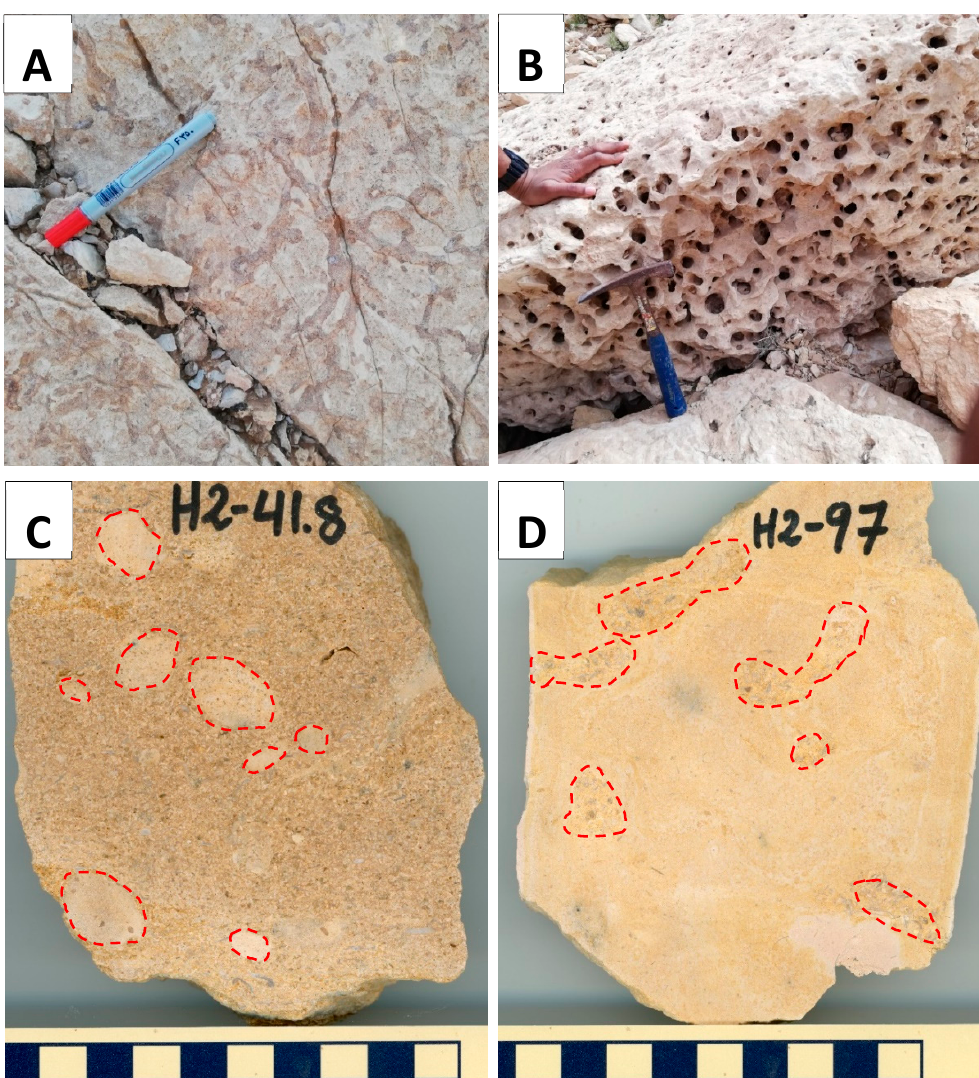
Figure 6. Thalassinoides burrows of the Hanifa Formation. Outcrop photos showing burrows filled with coarser materials than matrix ( A ), or partially to completely unfilled burrows ( B ). Pen ( A ) and hammer for scale ( B ). Scan of two of the studied samples showing burrows filled with ( C ) fine material in grain-dominated matrix highlighted by red dotted lines, and ( D ) coarse fill in mud-dominated matrix. Scale bar in cm in ( C , D ).